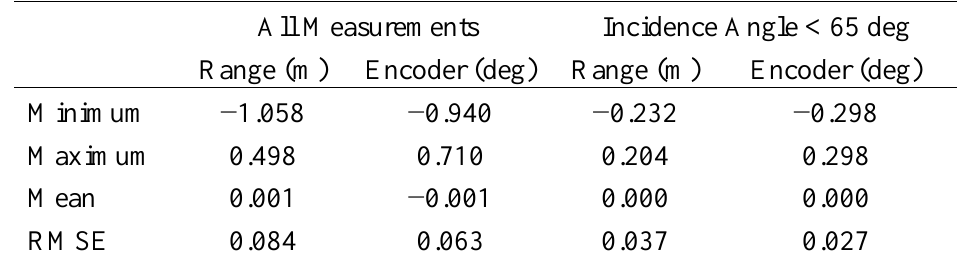
Table 4. Range and Encoder Angle Residuals (All Points and Points With Planar Incidence <